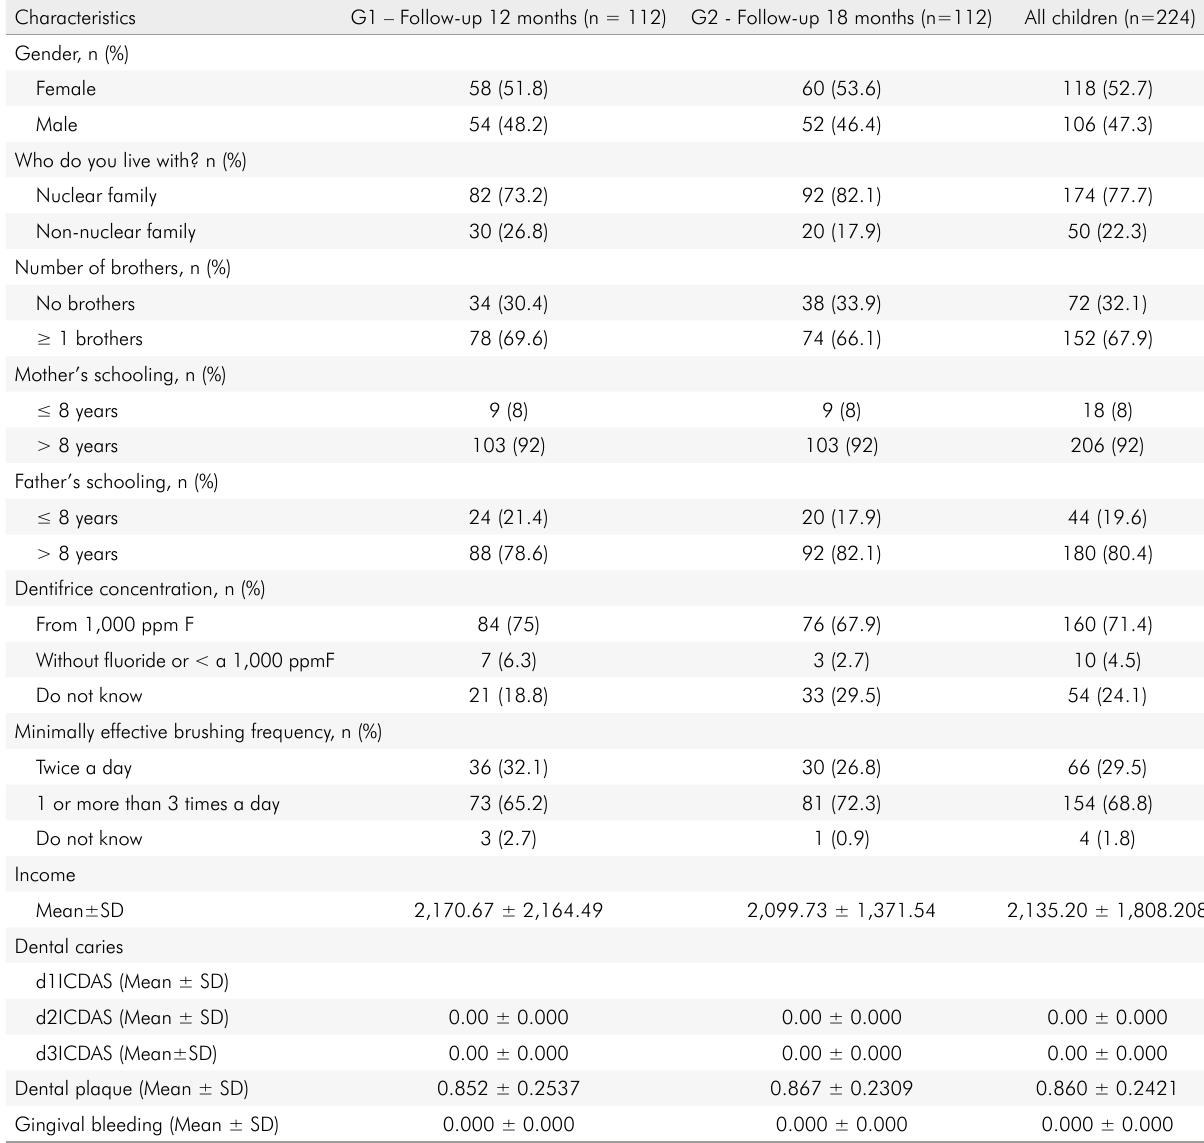
Table 1. Characteristics of randomized participants for the study groups at the baseline (G1 and G2).